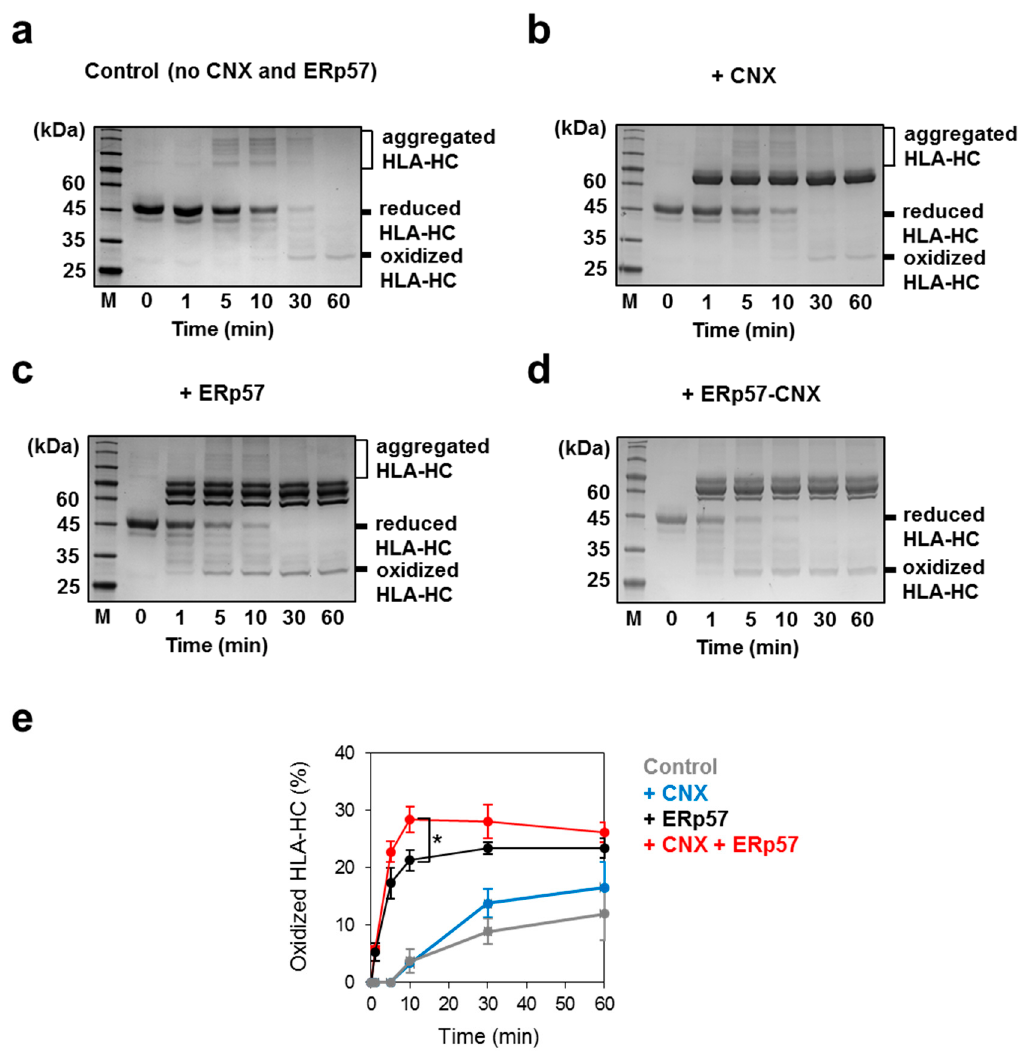
Figure 3. A mixture of ERp57 and CNX rapidly introduces disulfide bonds into HLA-Cw4. These panels show a time course of HLA-HC oxidation catalyzed by CNX and/or ERp57. Reduced and denatured HLA-Cw4 (5 μ M) was incubated without CNX/ERp57 as a control ( a ), and with CNX ( b ), ERp57 ( c ), or CNX/ERp57 ( d ) under redox conditions (GSH:GSSG = 2 mM:1 mM). Reactions were quenched with 10 mM maleimide-PEG-2k at the selected time points and proteins were separated by non-reducing SDS-PAGE (10% polyacrylamide gels). Experiments were independently repeated three times with reproducible results. ( e ) Quantification and statistical analysis of the fraction of oxidized HLA-HC shown in Figure 3a–d. The relative band intensities of oxidized HLA-HC were quantified compared to the band intensity of reduced HLA-HC ( n = 3, mean ± SD). * p < 0.05.